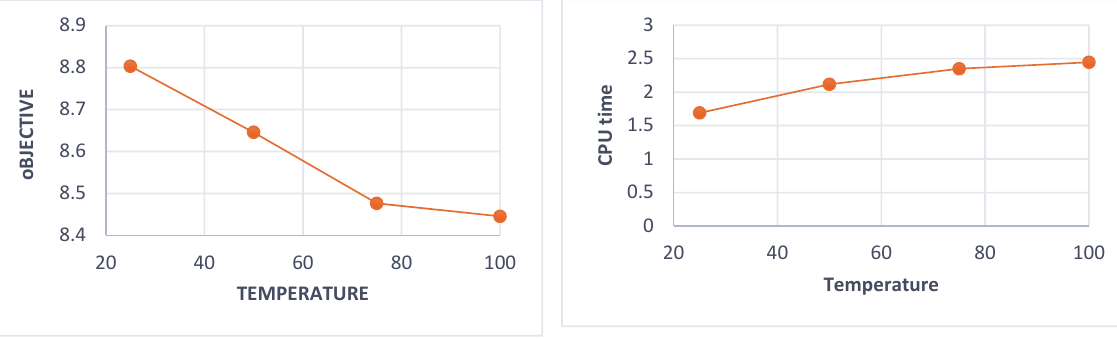
Fig. 4 . The effect of highest temperature on the objective value